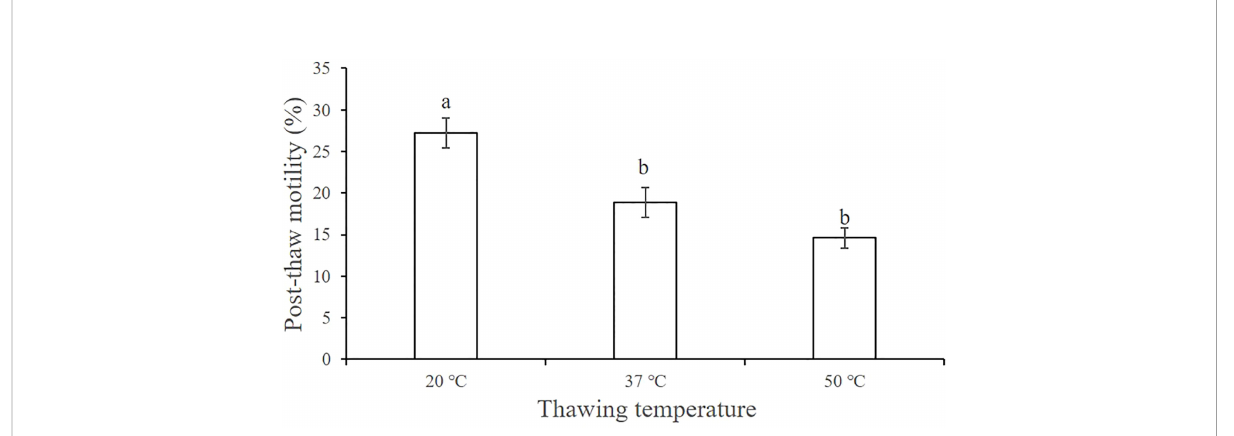
FIGURE 4 Effect of the thawing temperature on the post-thaw motility of A. japonicus spermatozoa. Data are presented as the means ± SE (n = 6). Different letters indicate signi fi cant differences (P < 0.05). Data were not transformed when performing one-way ANOVA.